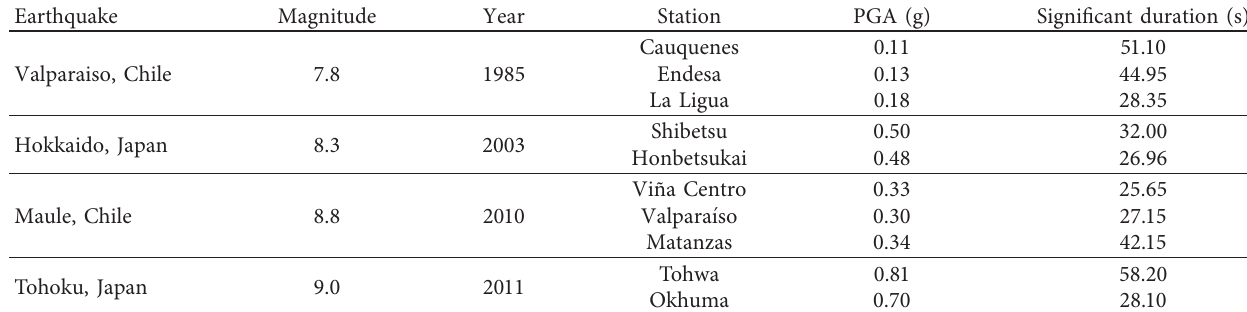
Table 3: Long-duration set summary.